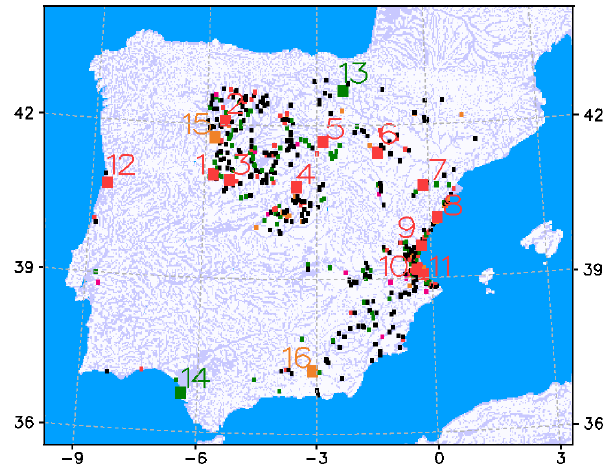
Figure 4. Shallow water table zones (light blue shades) and Iberian Peninsula wtd observation stations (dots). Red dots are locations where observed and simulated wtd differences are within 2m; green dots are stations with correlation over 0.5 between observed and simulated wtd series (full time series available in the observed data); purple dots are stations with steep wtd slope ( ≥ 0 . 035m per month), well captured by the model; orange dots are cells containing more than one observation station; black dots are cells where none of the above criteria is met by the model. Over cells where more than one validation criteria is reached the point adopts the colour of the first criterium met (in the order presented here); for instance, cells with mean wtd differences lower than 2m and also correla- tions above 0.5, are shown as red on the